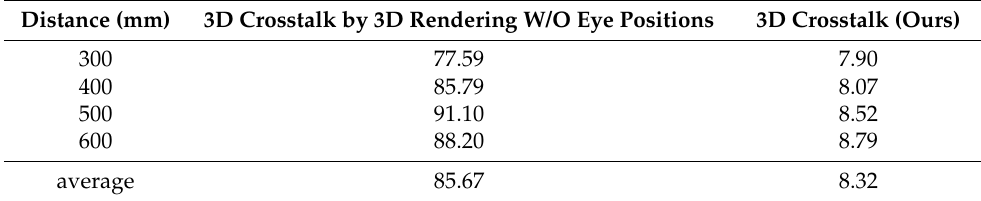
Figure 10. Examples of the two-view image captured at different distances: ( a ) captured images of rendering without eye positions, ( b ) captured images using the proposed 3D light field rendering method with eye positions. Table 2. Extrinsic crosstalk evaluation results.